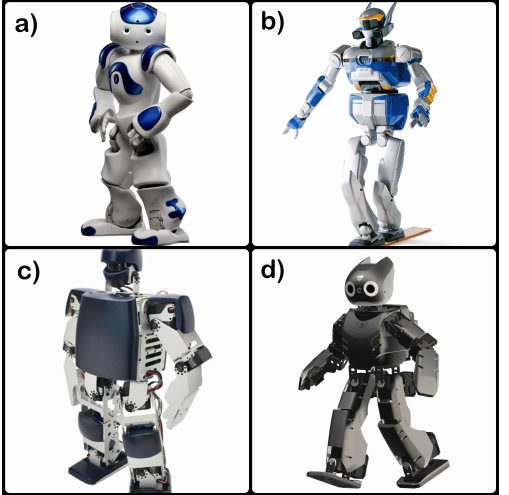
Figure 3. Humanoids: ( a ) NAO (Nao Humanoid), ( b ) HRP 2, ( c ) KT-X, and ( d )